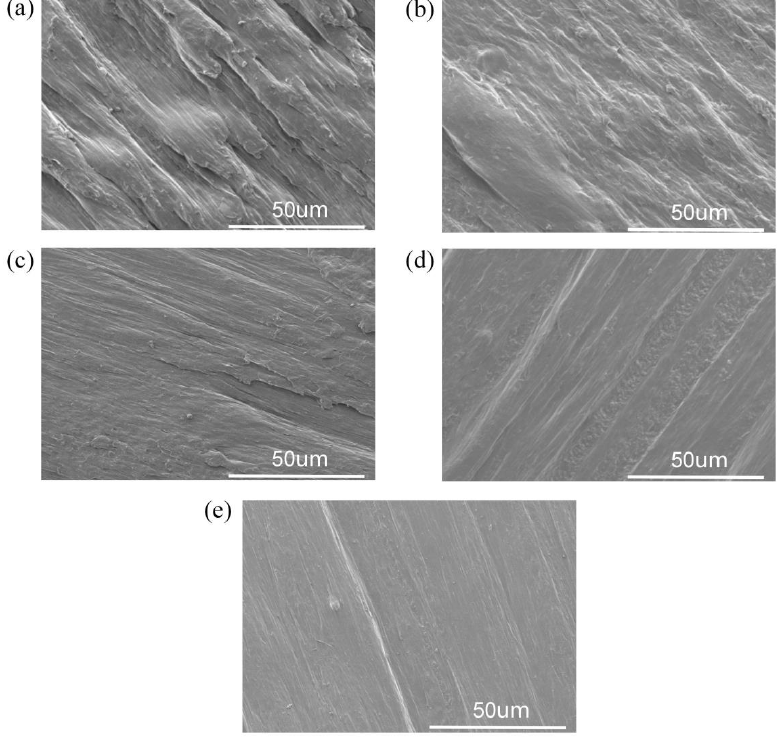
Figure 4. Scanning electron microscopy images of PPCE samples with different degrees of CE: ( a ) PPCE-0, ( b ) PPCE-0.6%, ( c ) PPCE-0.9%, ( d ) PPCE-1.2%, and ( e ) PPCE-1.5%.